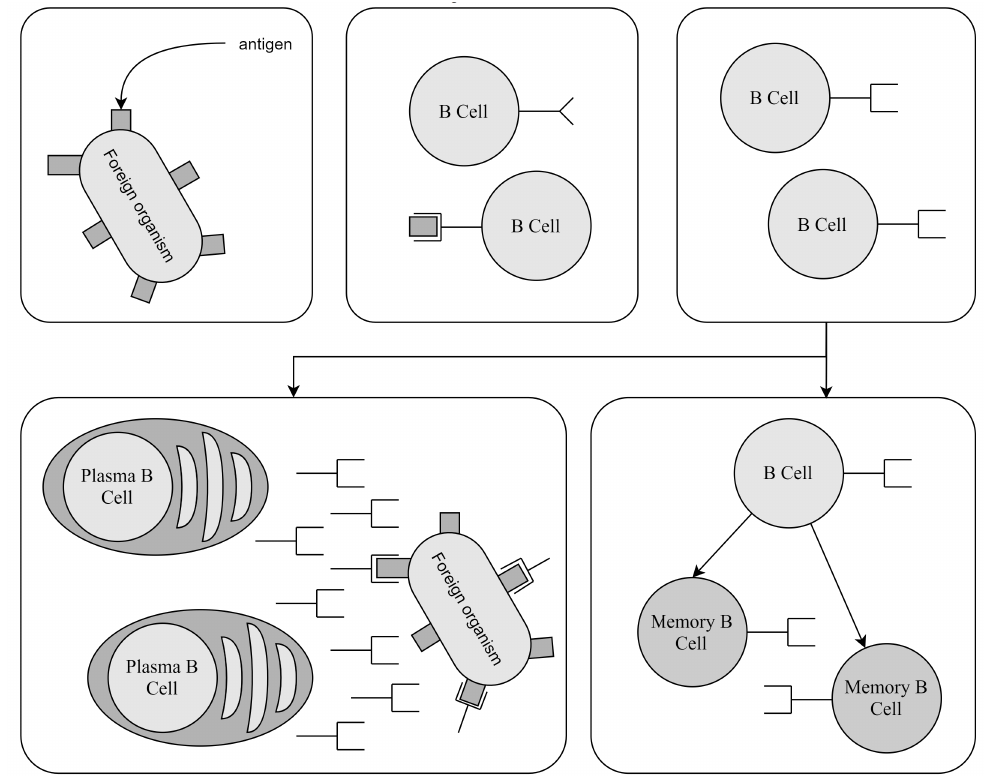
Figure 3. Simplified diagram of clonal selection theory. A foreign organism contains specific antigen that can be recognized by B cells ’ receptors with high affinity. B cells that recognize those antigen are cloned, resulting in plasma cells and memory cells . Short-lived plasma cells release antibodies that bond to the considered antigen and inhibit the foreign organism. Long-lived memory cells will react quickly in future occurrences of same antigens